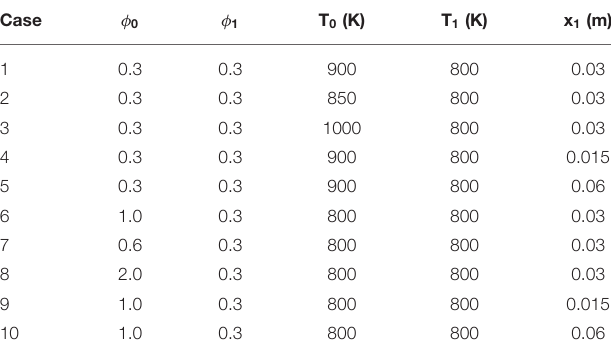
TABLE 1 | Case setup including initial temperature and concentration